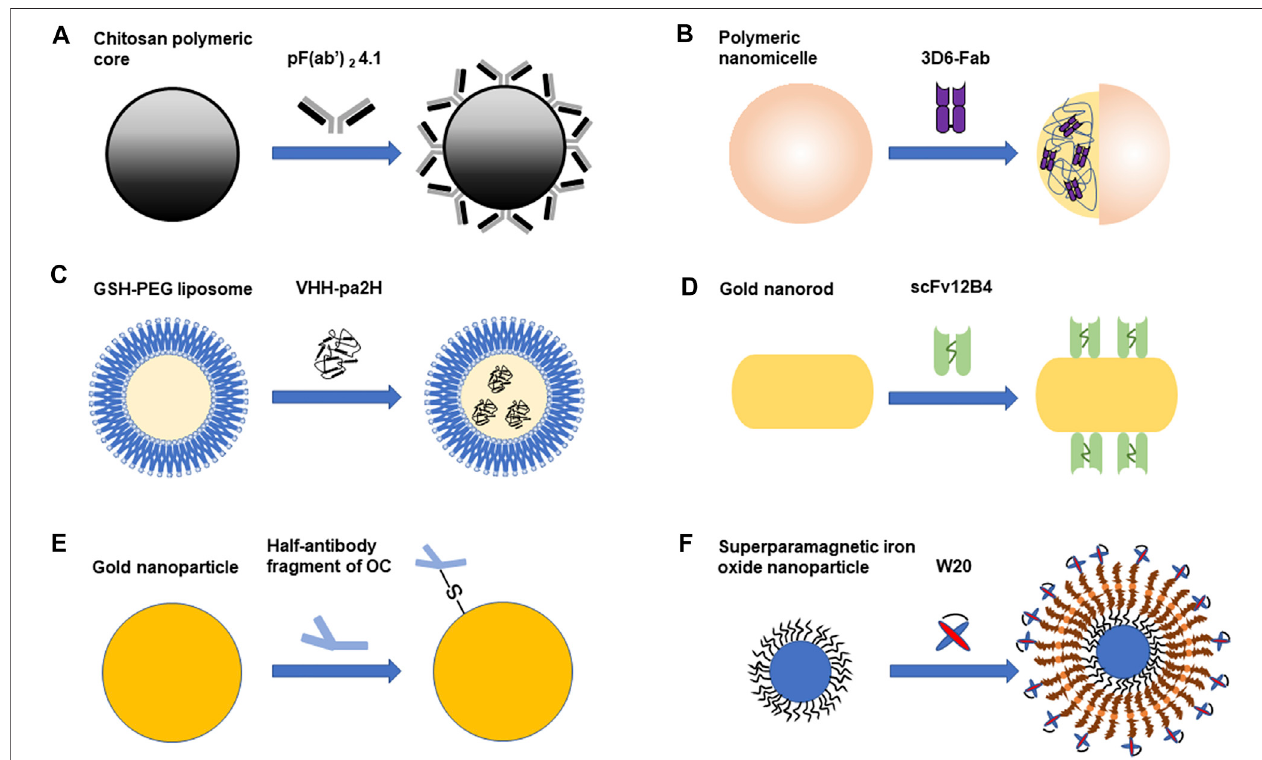
FIGURE1| ThecombinedapplicationofantibodyfragmentsandnanoparticlesinAlzheimer ’ sdisease. (A) .PF(ab ’ ) 2 4.1coverthesurfaceofthechitosanpolymeric core. (B) .Polymericnanomicelleencapsulates3D6-Fab. (C) .GSH-PEGliposomeencapsulatesVHH-pa2H (D) .ScFv12B4arecombinedwithgoldnanorod(GNR). (E) . Half-antibody fragment of OC is combined with gold nanoparticle (AuNP). (F) . W20 is combined with superparamagnetic iron oxide nanoparticle (SPION). Different antibody fragments combine with different nanoparticles. Some antibody fragments are on the surface of the nanoparticle, while some are encapsulated in the nanoparticle. The combination of antibody fragments and nanoparticles can be used in the diagnosis or treatment of Alzheimer ’ s disease.